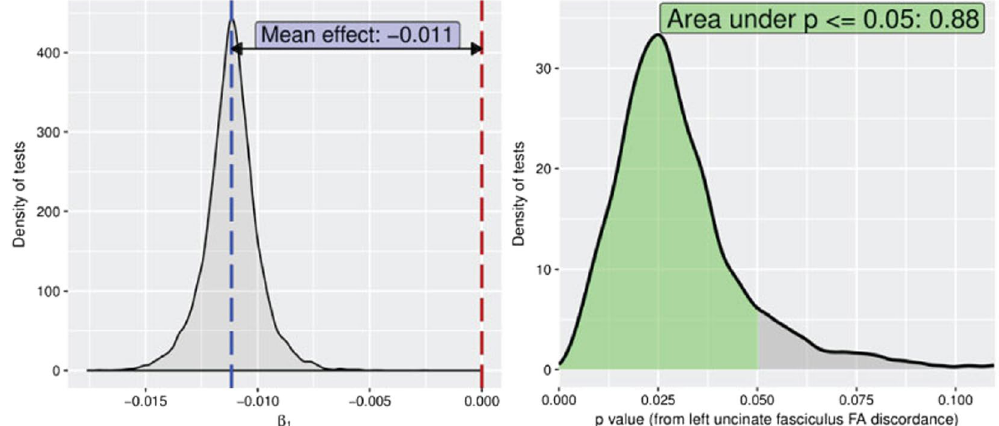
Figure 3. Distribution of beta (left panel) and p values (right panel) of association between anxiety and FA difference score after switching twin assignment 10 4 times. 88% of the p values were lower than 0.05.